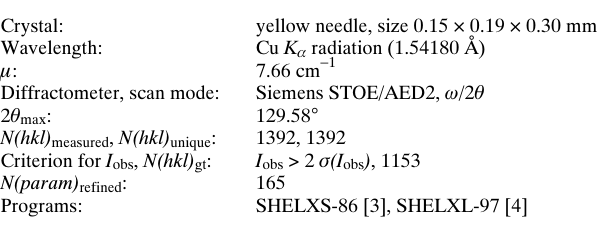
Table 1. Datacollection and handling.